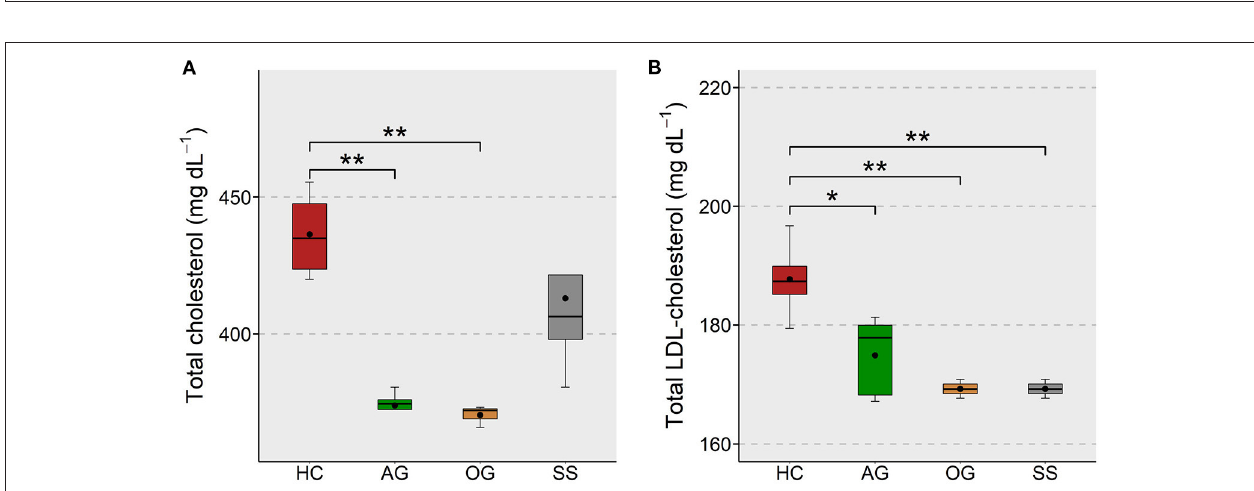
FIGURE 1 | Total and LDL-cholesterol levels in the plasma of zebrafish fed a low or a high cholesterol diet. Boxplots show the total cholesterol (A) and LDL-cholesterol (B) levels (mg dL − 1 ) in the plasma of zebrafish fed either a control (CT) diet or a high cholesterol (HC) diet for a period of 12 weeks. Black dots inside each box indicate the mean values of the corresponding groups. * indicates p < 0.05 and • indicates p < 0.1.